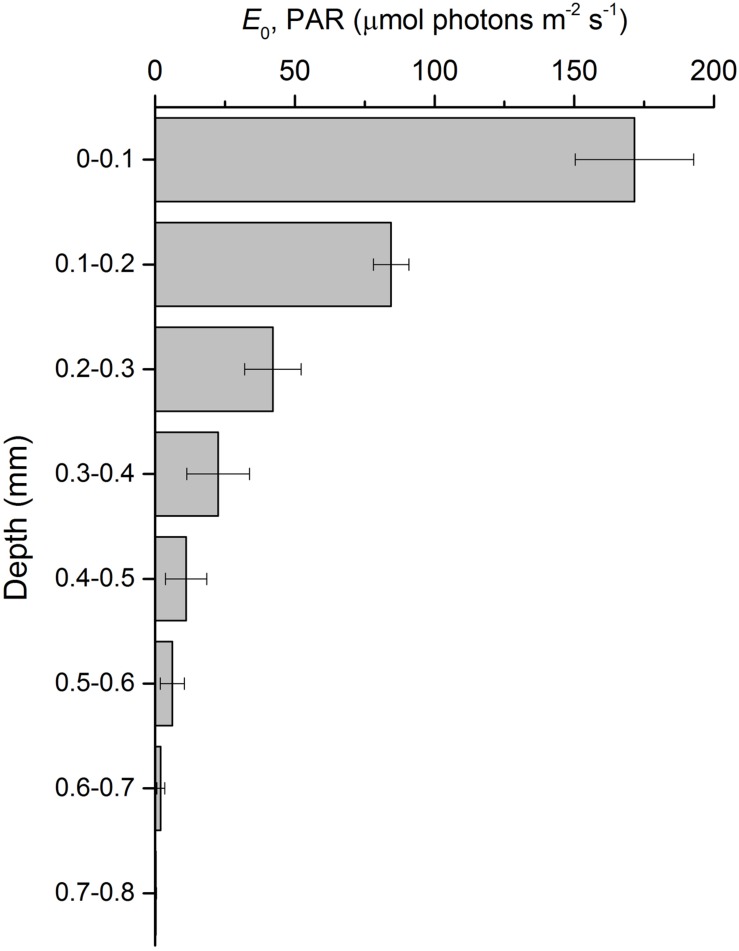
Scalar irradiance profile of photosynthetically active radiation (E0, PAR) in an intertidal sediment illuminated at a constant irradiance of 150 μmol photons m-2 s-1 (mean ± standard deviation; n = 3).